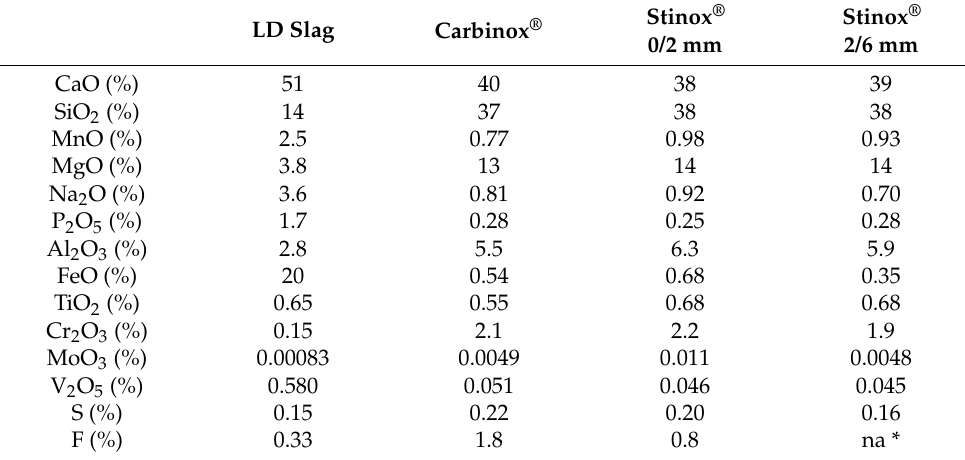
Table 1. Chemical composition of the LD slags and Carbinox ® and Stinox ® from stainless-steel slags determined by ED-XRF analysis, except for F, which was measured by ion-selective electrode analysis after hydro-pyrolysis of the solid